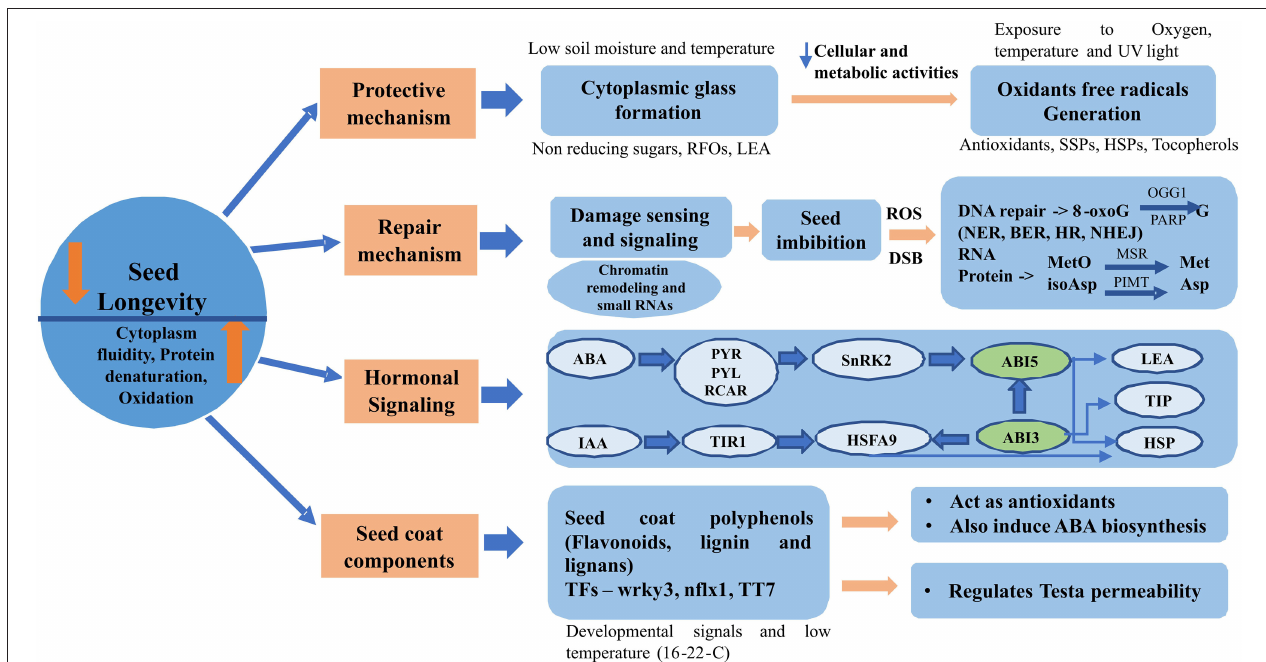
FIGURE 2 | Molecular mechanisms involved in regulating seed longevity during storage. ABA: abscisic acid, BER: base excision repair, DSB: double strand breaks, HR: homologous repair, SSP: seed storage proteins, HSP: heat shock protein, IAA: indole-3-acetic acid, LEA: late embryogenesis abundant, MSR: methionine sulfoxide reductase, NHEJ: non-homologous end joining, NER: nucleotide excision repair, PIMT: protein L -isoaspartyl methyltransferase, PYR/PYL/RCAR: pyrabactin resistance/PYR1-like/regulatory components of ABA receptors, RFOs: raffinose family oligosaccharides, ROS: reactive oxygen species, snRK2: sucrose non-fermenting 1- related subfamily 2, TIP: tonoplast intrinsic protein, TIR1: transport inhibitor response 1, TF: transcription factor.